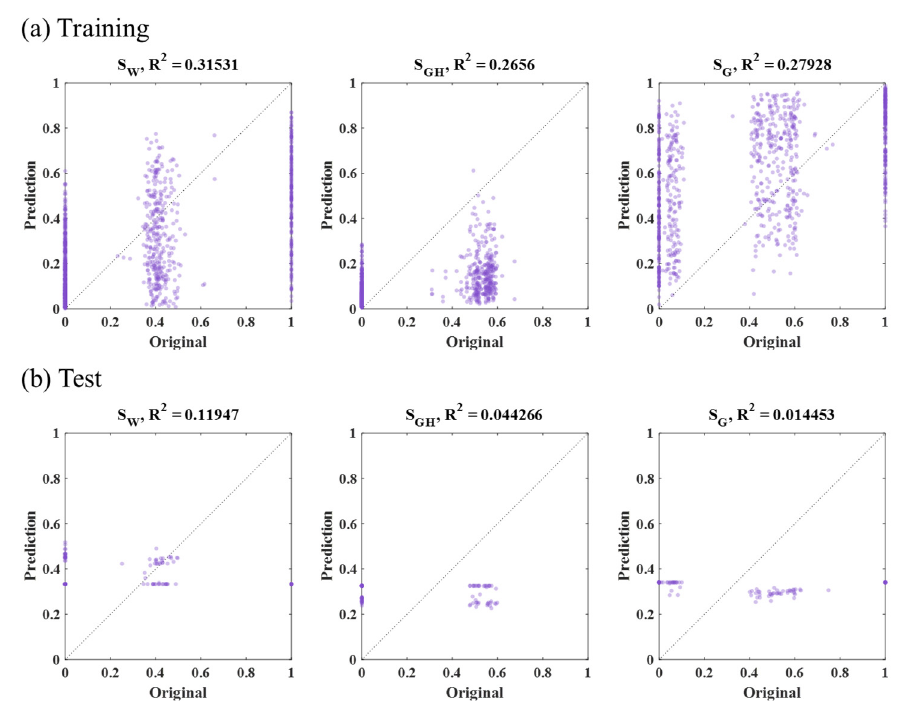
Figure 13. The training ( a ) and test ( b ) results from the CNN with the inner squared input data (Figure